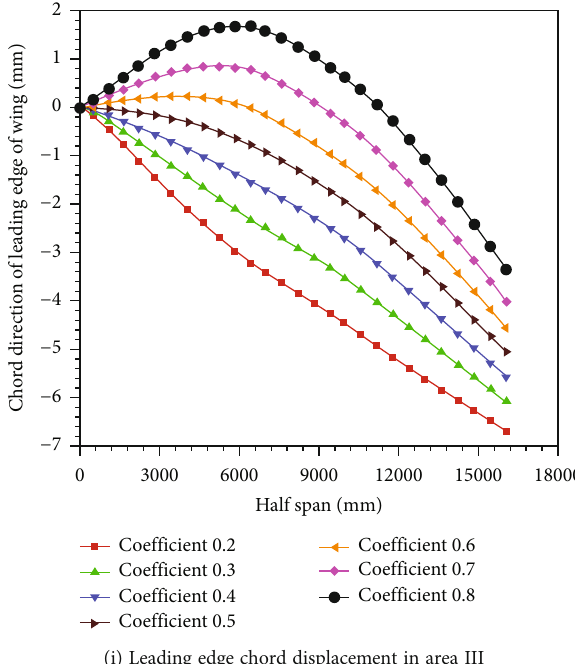
Figure 13: Displacement comparison in di ff erent directions in each laminated